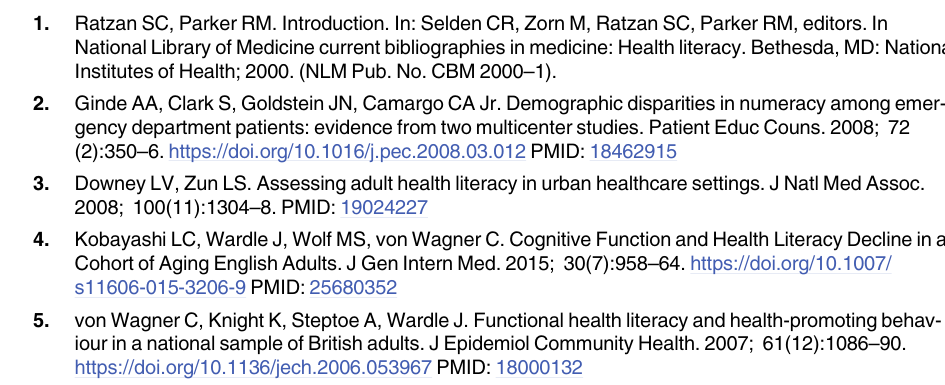
S1 Table. Social demographic characteristics of participants in the cognitive test of the